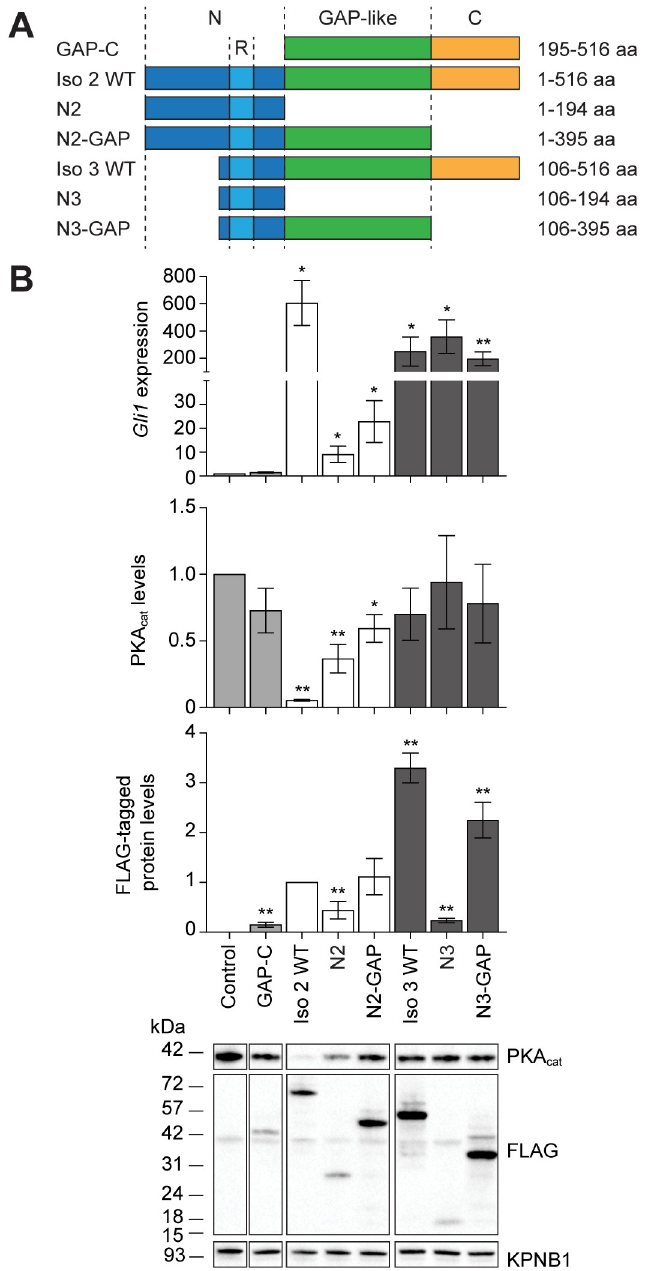
Fig 3. The C-terminal domain counteracts an autoinhibitory N-terminal sequence. (A) Schematic representation of ARHGAP36 isoform 2 or 3 truncation mutants. Residue numbers are based on the amino acid sequence of isoform 2. (B) Gli1 mRNA and PKA cat protein levels in NIH-3T3 cell retrovirally transduced with the indicated FLAG-tagged ARHGAP36 truncation mutants. Data are the average fold change relative to uninfected cells ( Gli1 mRNA or PKA cat protein levels) or to cells expressing ARHGAP36 isoform 2 (FLAG-tagged protein levels) for three biological replicates ± s.e.m. Single and double asterisks indicate P < 0.05 and P < 0.01, respectively. Representative western blots for each condition are shown, with the importin β 1 subunit (KPNB1) used as a loading control (lanes from the same blot image have been cropped and re-ordered for clarity).